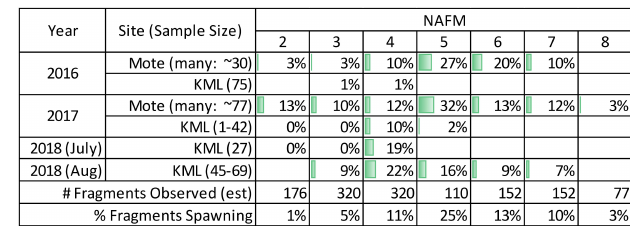
TABLE 2 | Percentage of observed ex situ Dendrogyra cylindrus fragments that spawned on each night after the full moon (NAFM).